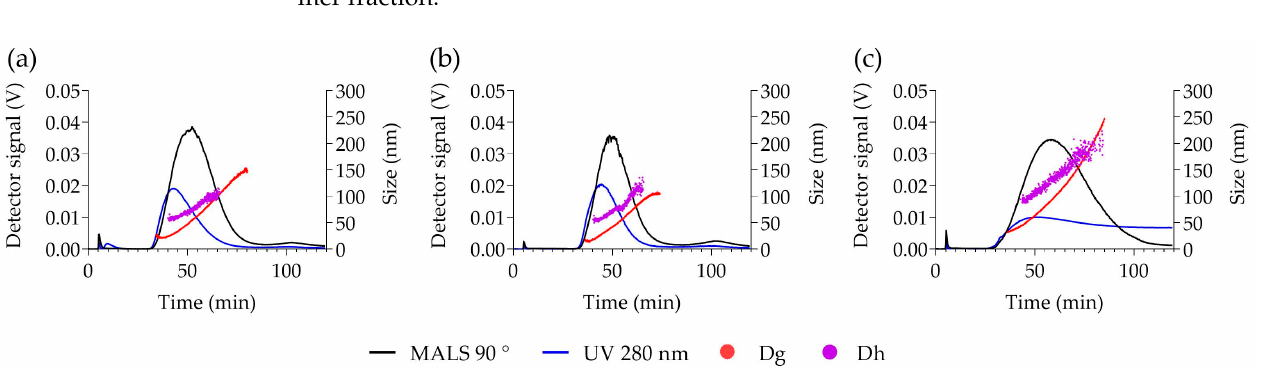
Figure 2. AF4-UV-MALS-DLS elution profiles of ( a ) PVAL-COOH SPIONs, ( b ) PVAL-OH SPIONs and ( c ) PVAL-NH 2 SPIONs (+). Scattered light from MALS at 90 ◦ (black) values are plotted on the left axis. Both Dg (red) and Dh (blue) sizes are plotted on the left axis. The Dg was calculated by fitting the MALS 9 angles data with the random coil model.